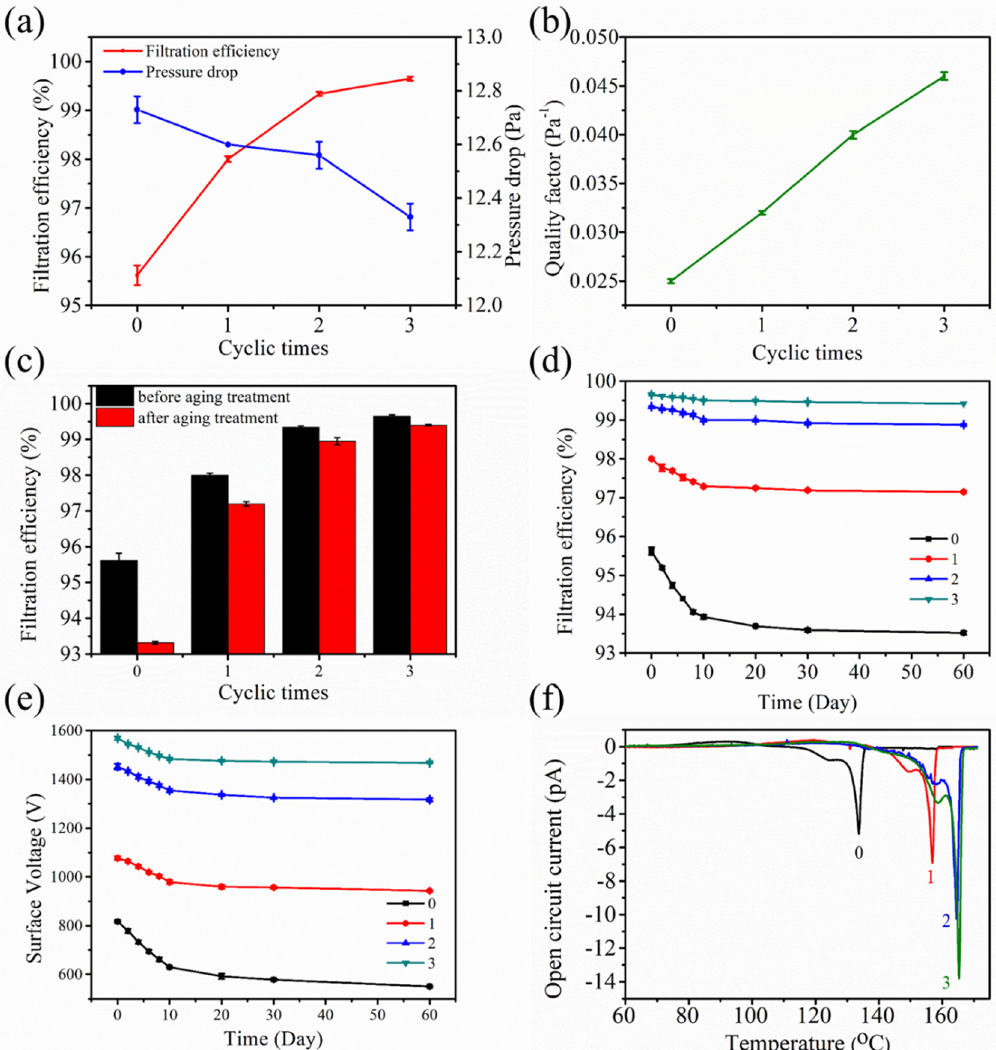
Figure 8 . Filtration and electret performances of the samples with cyclic corona charging: ( a ) filtration efficiency and pressure drop, ( b ) QF , ( c ) filtration efficiency after the aging treatment, ( d ) filtration efficiency decay after two months, ( e ) surface voltage decay after two months, ( f ) open-circuit TSD current .